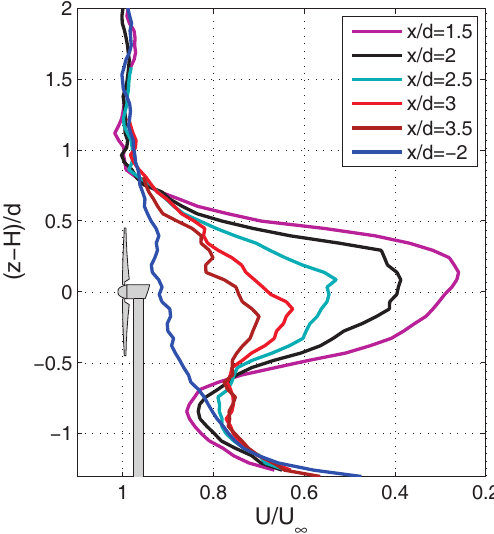
Figure 2. Vertical velocity profiles obtained through simultaneous RHI scans.